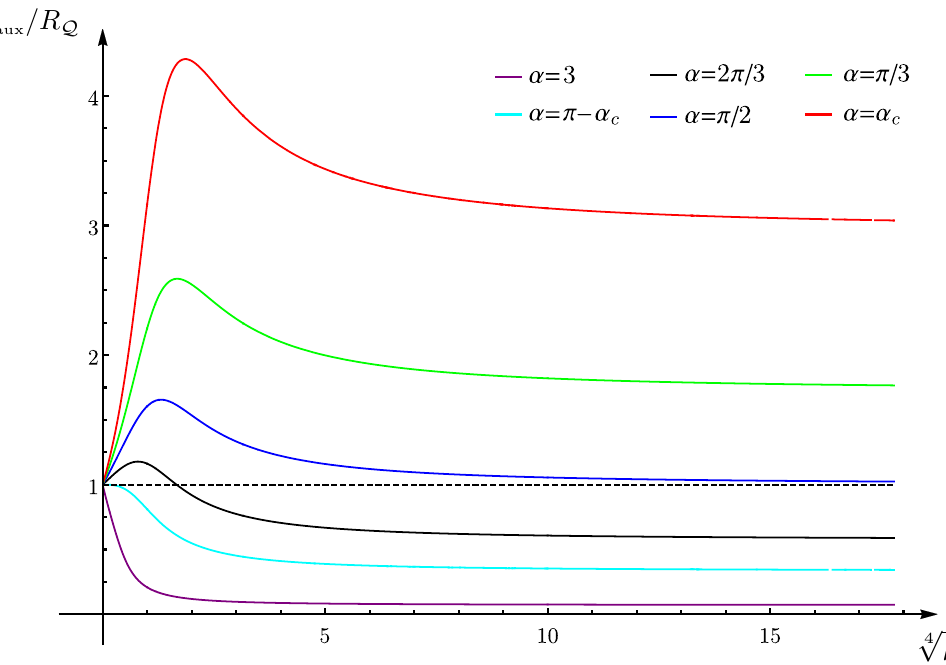
Figure 17 . The ratio R =R Q for a disk A concentric to a circular boundary of radius R Q (see aux section 4.1.1 and appendix D) in terms of the parameter k , obtained by combining (4.4) and